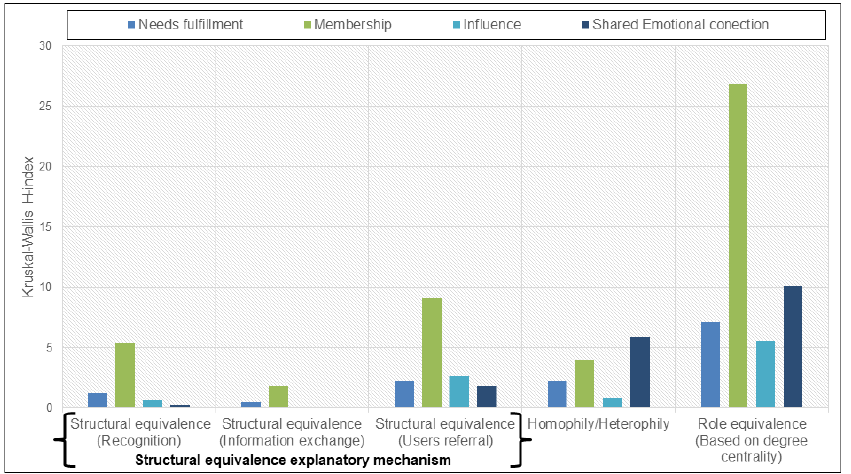
Figure 5 . Kruskal – Wallis H-index values in the PSC dimensions in the structural cohesion, homoph- ily/heterophily and role equivalence